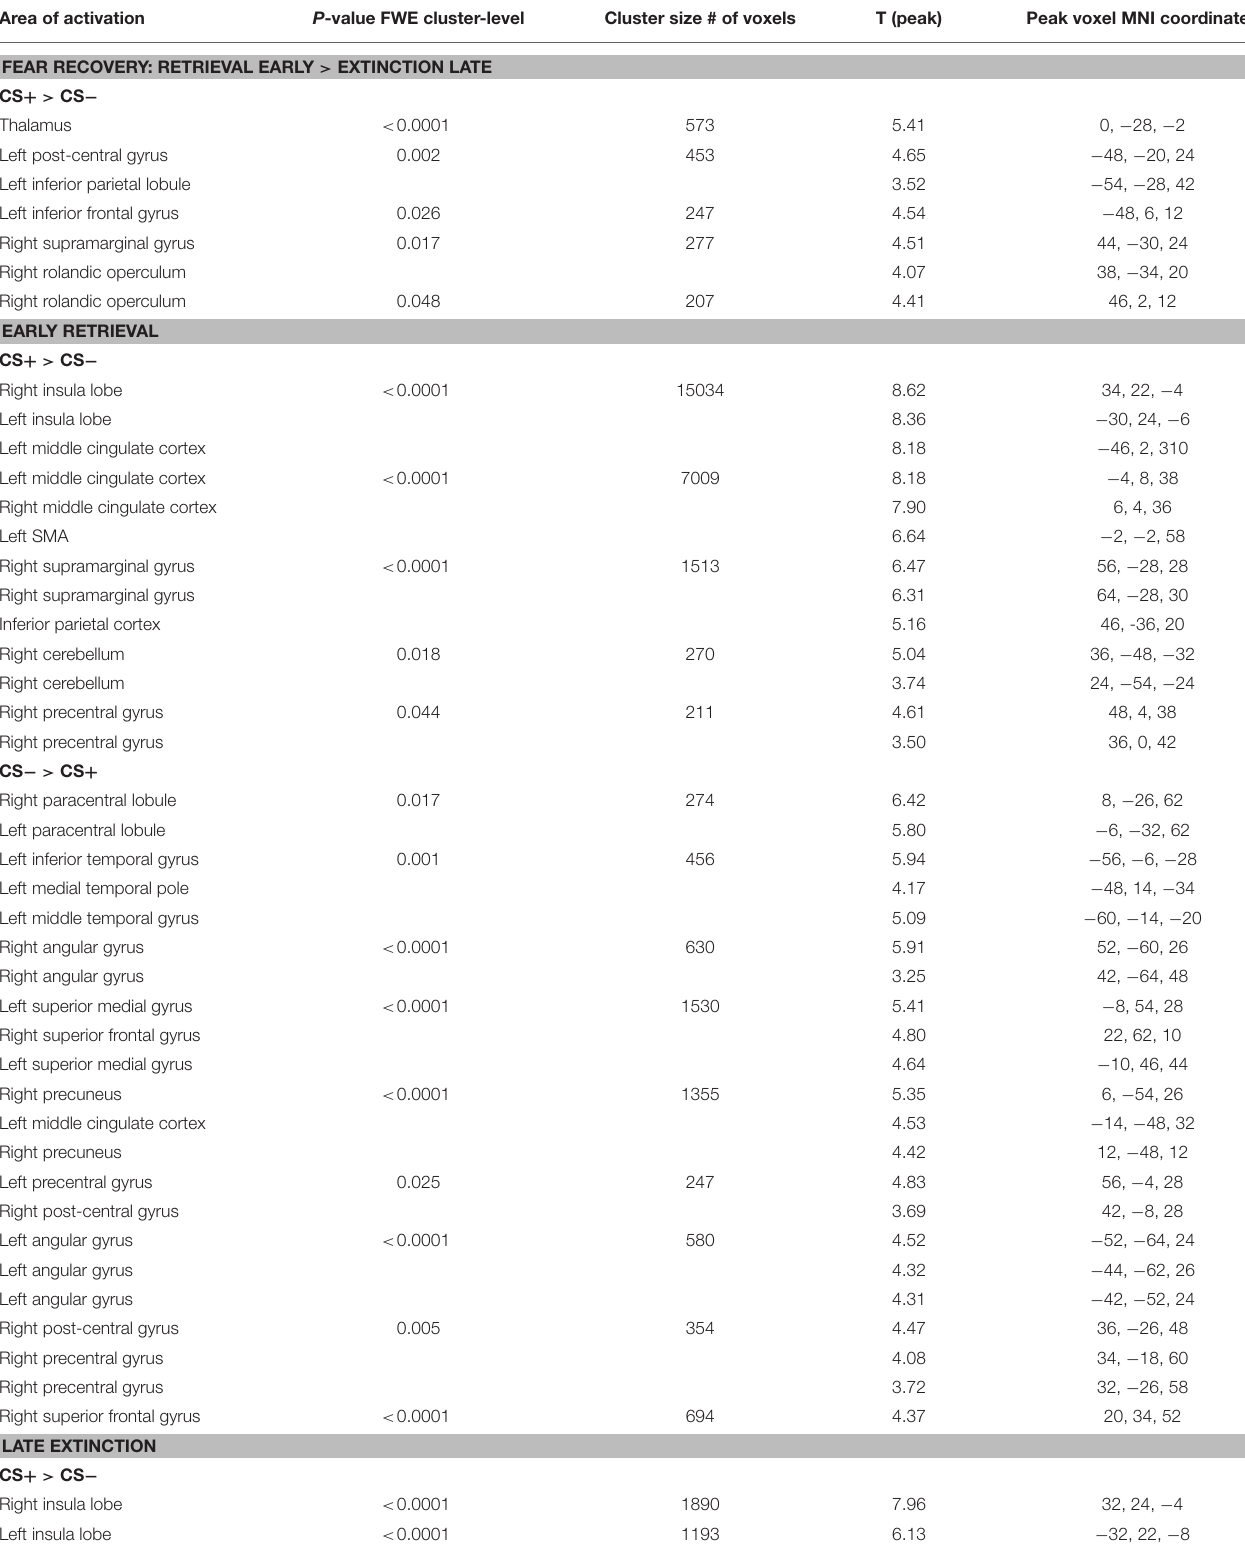
TABLE 2 | Group activation for fear recovery, late extinction and early extinction retrieval. Area of activation P -value FWE cluster-level Cluster size # of voxels T (peak) Peak voxel MNI